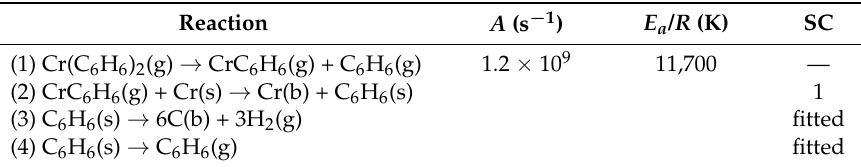
Table 5. Kinetic data in the form defined by Equations (7) and (8).